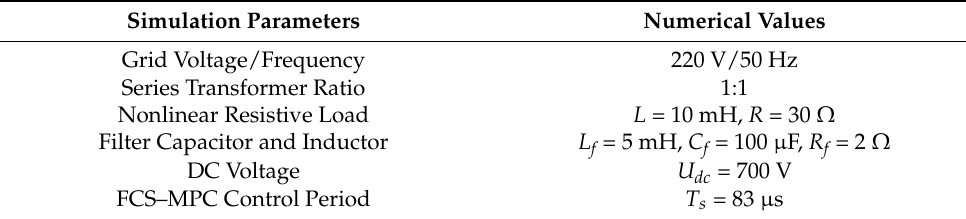
Table 1. Main simulation parameters. Simulation Parameters